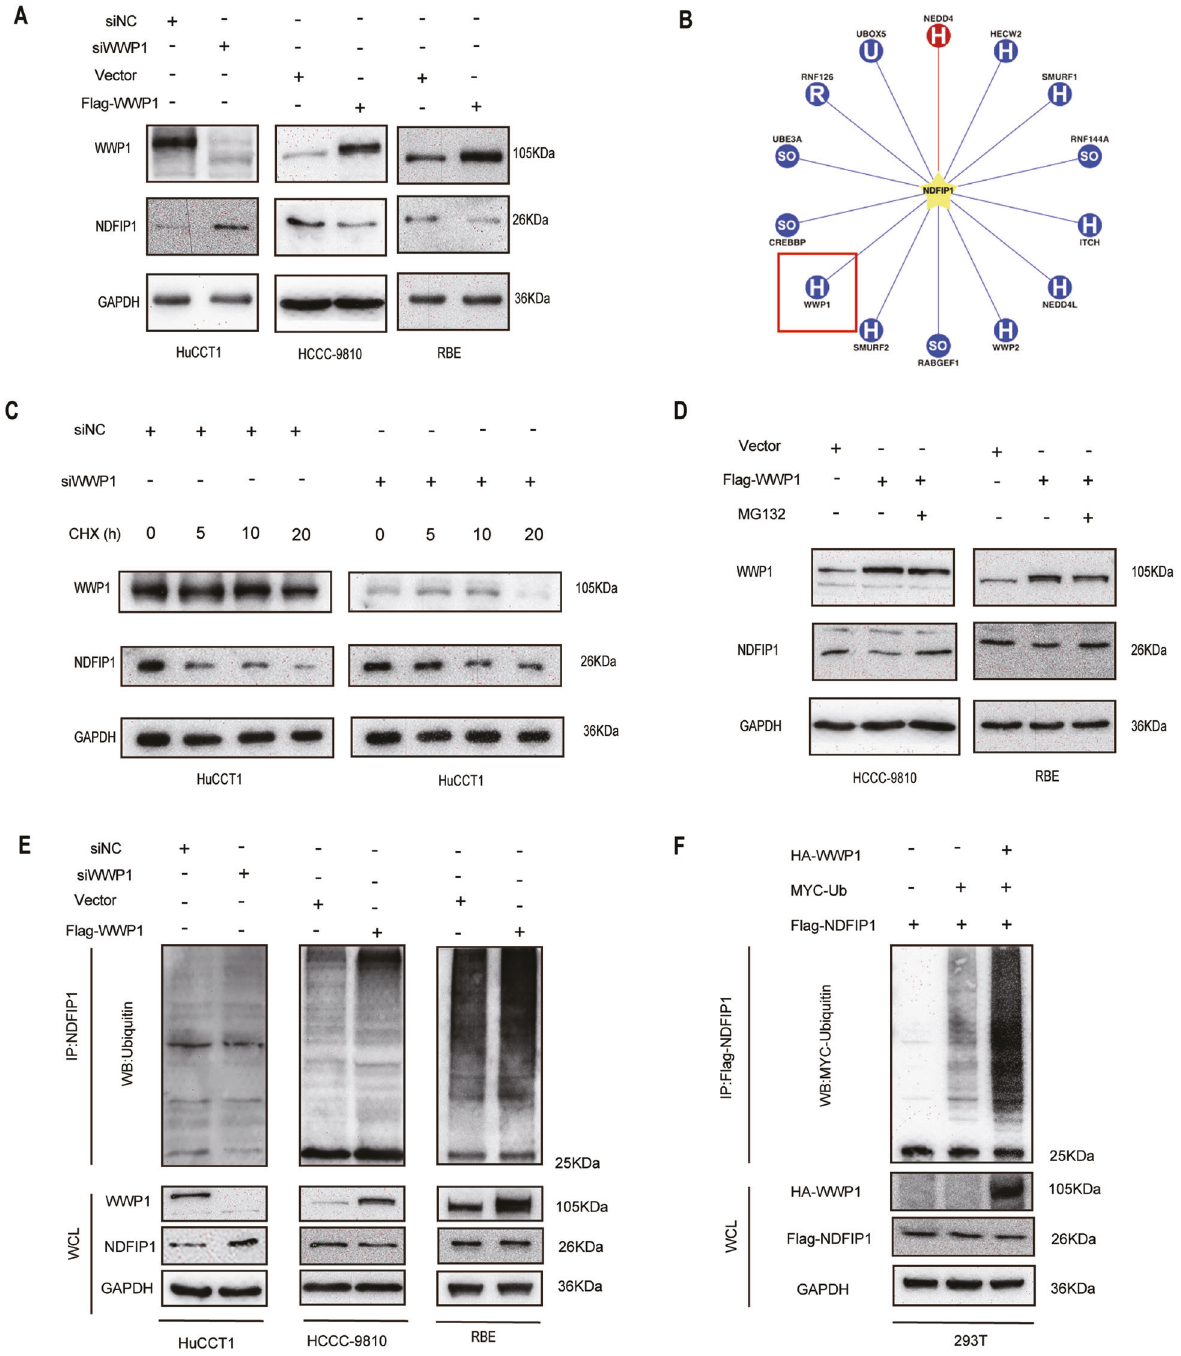
Fig. 7 WWP1 targeted NDFIP1 for ubiquitination and degradation. A The protein level of NDFIP1 in HuCCT1 cells with WWP1 knockdown was evaluated by western blotting. The protein levels of NDFIP1 in HCCC-9810 and RBE cells with WWP1 overexpression were measured by western blotting. B Using UbiBrowser Database (http://ubibrowser.ncpsb.org/), NDFIP1 was predicted to be ubiquitinated by WWP1. C HuCCT1 cells infected with the lentiviral shWWP1 and control lentivirus were incubated with 100 ug/ml cycloheximide (CHX) for the indicated time. The half-life of NDFIP1 was evaluated by western blotting. D The protein level of NDFIP1 in HuCCT1 cells with WWP1 knockdown, HCCC-9810, and RBE cells with WWP1 overexpression treated with 20 μ M MG132, a potent proteasome inhibitor, for 4 h were analyzed by western blotting. E Ubiquitylation levels of NDFIP1 detected by Western blotting with anti-ubiquitin antibody after WWP1 knockdown and overexpression in HuCCT1, HCCC-9810, and RBE cell lines, respectively. F 293T cells were transfected with the indicated plasmids, the cell lysates were incubated with Flag-tagged beads and the ubiquitylation level of Flag-NDFIP1 was detected by western blotting with an anti-MYC antibody.